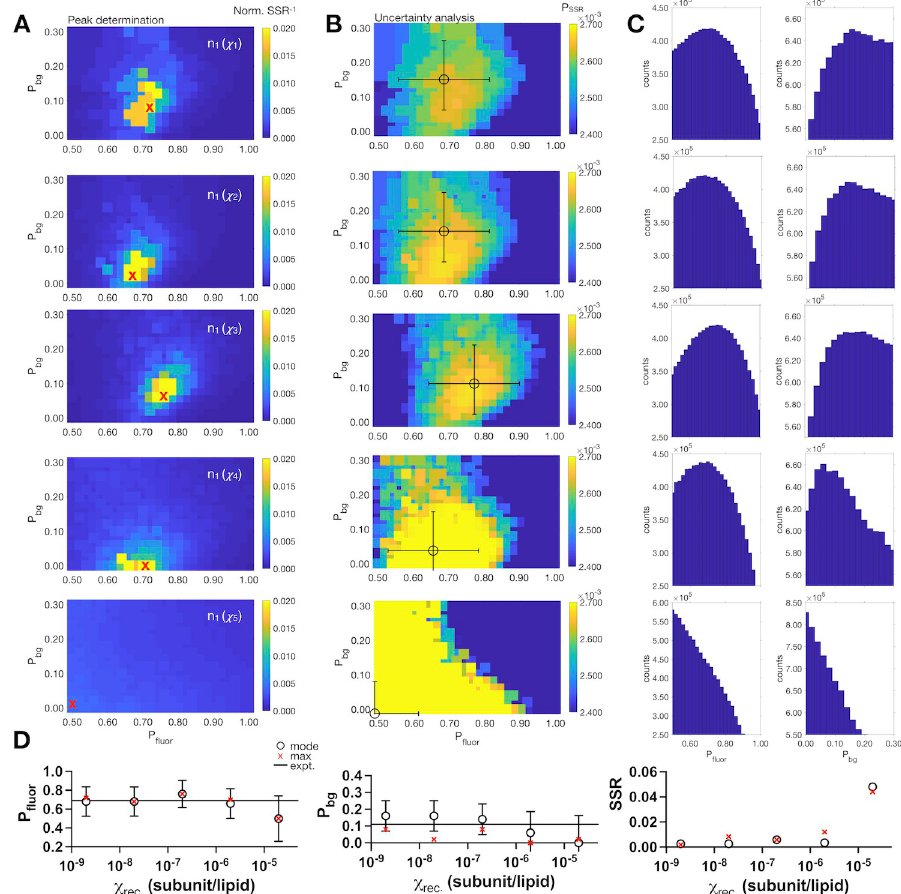
Fig 2. Single-molecule photobleaching estimation of ( P fluor , P bg ) for covalently cross-linked CLC-ec1 dimers across a wide range of protein densities. (A) Heatmaps of the inverse normalized sum of squared residuals ( Norm . SSR -1 ) over the fluorophore labeling parameter space of ( P fluor , P bg ). The experimental photobleaching data used in this analysis are from [25] for the covalently cross-linked R230C/L249C CLC-ec1 dimer, for a single sample ( n 1 ) across a 5-magnitude range in mole fraction densities: χ 1 = 2 x 10 − 9 , χ 2 = 2 x 10 − 8 , χ 3 = 2 x 10 − 7 , χ 4 = 2 x 10 − 6 , χ 5 = 2 x 10 − 5 subunits/lipid. Maximum value, corresponding to the ( P fluor , P bg ) pair that best fits the experimental data is indicated by the red "x". (B) Heatmaps of the probability distribution of the sum of squared residuals, P . (C) Bootstrapping SSR analysis from the P SSR distribution. The sampling number, N , is set to 10 7 . The mode and standard deviation around the mode, σ , from each bootstrapped distribution are marked in panel (B) with the circle and error bars, respectively. (D) Mode ± σ (circle ± error bars) and max values (red "x") of P and P from the bootstrapping analysis along with fluor bg SSR values compared to the experimental data.